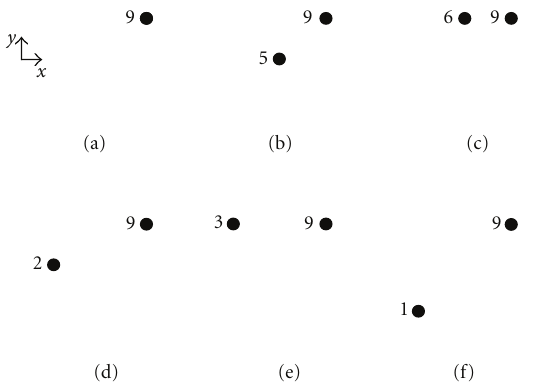
Figure 8: Required calculations for the receiving mutual impedance method based on symmetry considerations. In (a), the induced terminal current by the excitation of element 9 in the absence of the other elements using an external incident plane wave is calculated. In (b)–(f), the induced terminal voltages of elements 5, 6, 2, 3, and 1 are separately calculated in the presence of element 9. The six calculations are su ffi cient to fill the coupling matrix estimate completely.